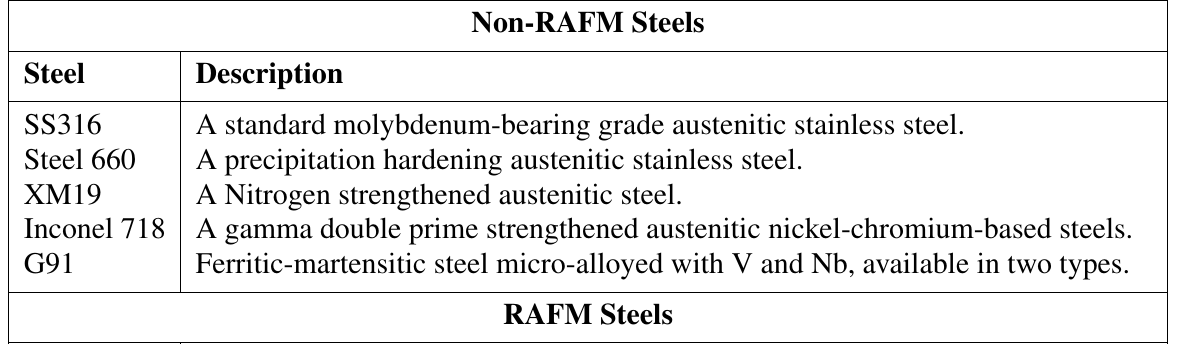
Table 2: A description of the steels studied separated between RAFM and